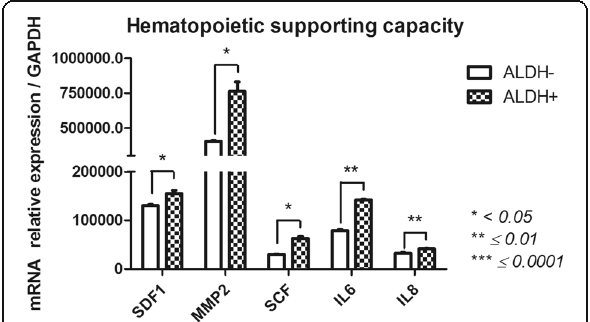
Fig. 8 Pro-hematopoietic-related gene expression profile of FSK-MSC subsets according to ALDH activity. After flow cytometry sorting of ALDH+ and ALDH- FSK-MSC subsets, we investigated by qPCR the expression profiles of pro-hematopoietic-associated genes SDF1, MMP2, SCF, IL6 and IL8 . Data are presented as mean ± SEM of mRNA gene expression relative to GAPDH expression